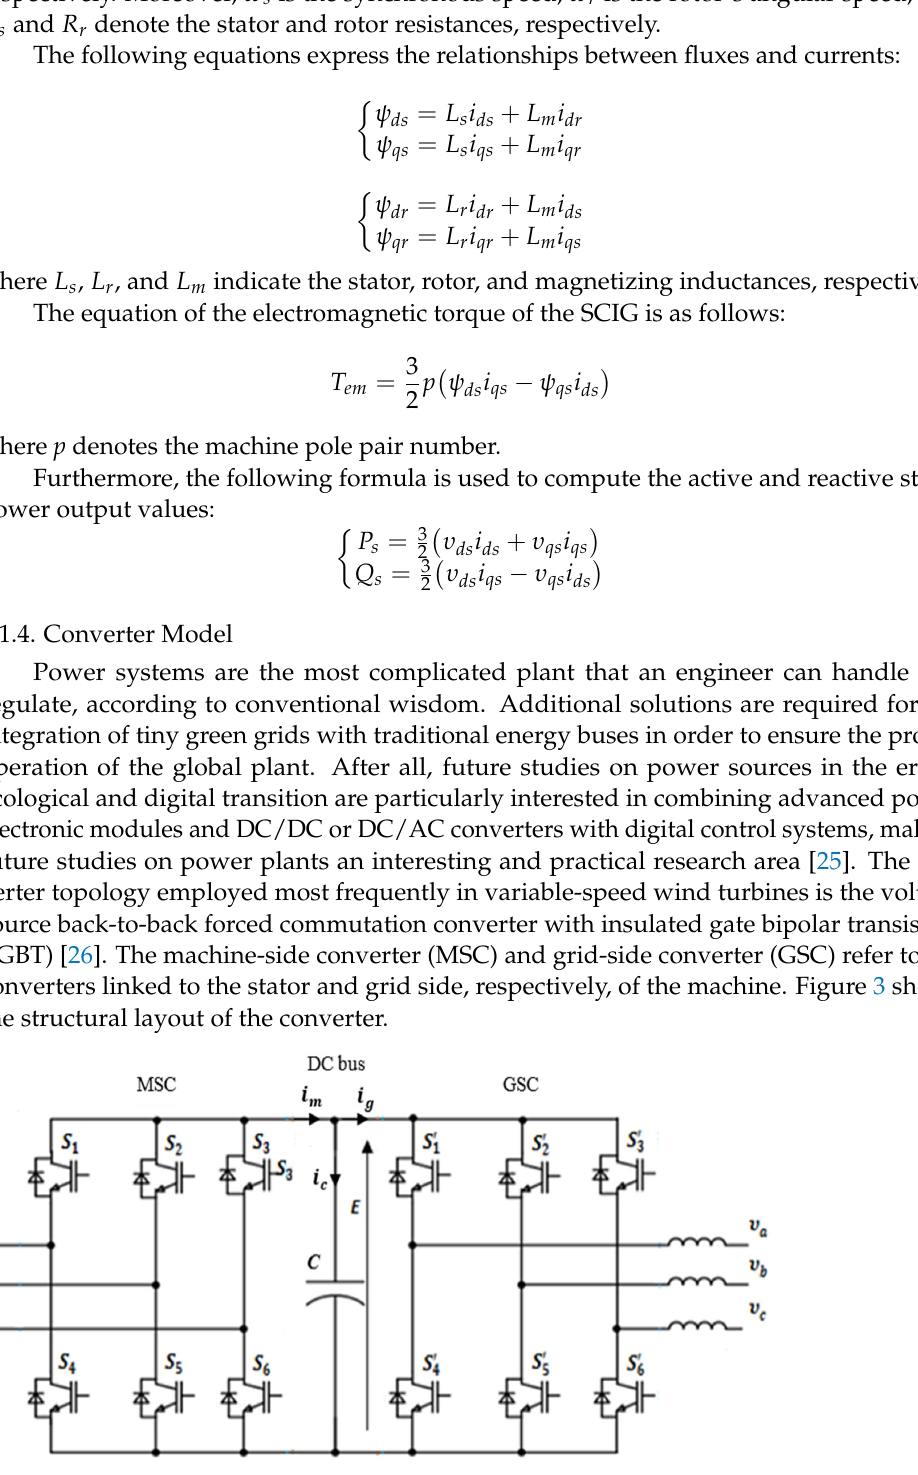
Figure 3. Back-to-back converter for IGBT voltage source converter.